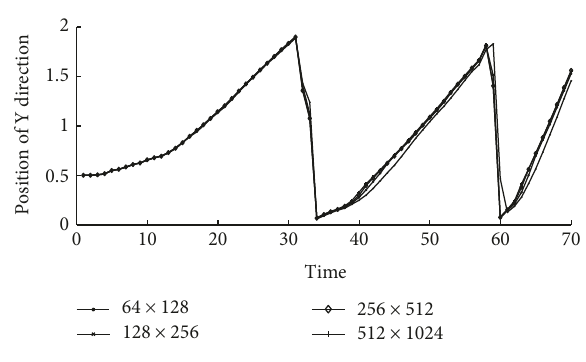
Figure 3: Grid convergence